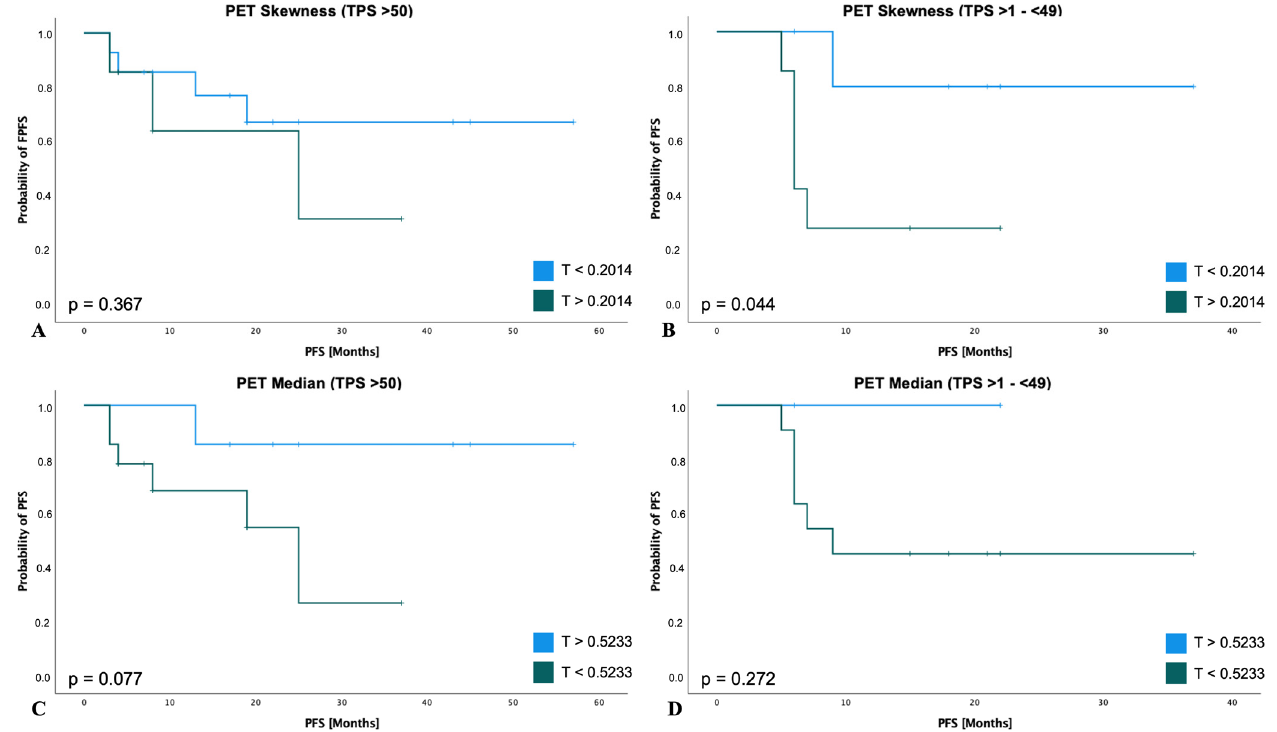
Figure 5. PFS subgroup analyses of RFs according to TPS. TPS > 50% subgroup ( n = 21): For PET- Skewness ( A ) patients had a lower probability of disease progression or death with a value below a threshold of 0.2014 (HR: 0.57; 95% CI, 0.22 to 1.48; p = 0.247). For PET-Median ( B ) patients had a lower probability of disease progression or death with a value above a threshold of 0.5233 (HR: 0.26; 95% CI, 0.08 to 0.81; p = 0.021). TPS >1–(<49%) subgroup ( n = 13): For PET-Skewness ( C ) patients had a lower probability of disease progression or death with a value below a threshold of 0.2014 (HR: 0.43; 95% CI, 0.13 to 1.40; p = 0.163). For PET-Median ( D ) patients had a lower probability of disease progression or death with a value above a threshold of 0.5233 (HR: 0.80; 95% CI, 0.17 to 3.76; p = 0.785).